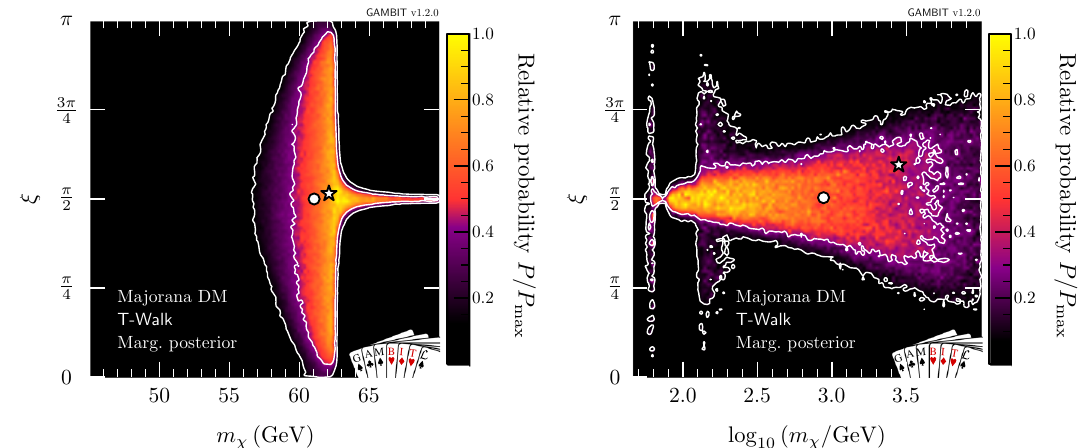
Fig. 9 Marginalised posterior distributions in the ( m χ ,ξ) plane for nance region around m χ ∼ m h / 2. The right panel shows a full-range Majorana fermion DM. Contour lines show the 1 and 2 σ credible parameter scan. The posterior mean is shown by a white circle, while regions. The left panel gives the result of a scan restricted to the reso- the maximum likelihood point is shown as a white star GAMBIT v1.2.0